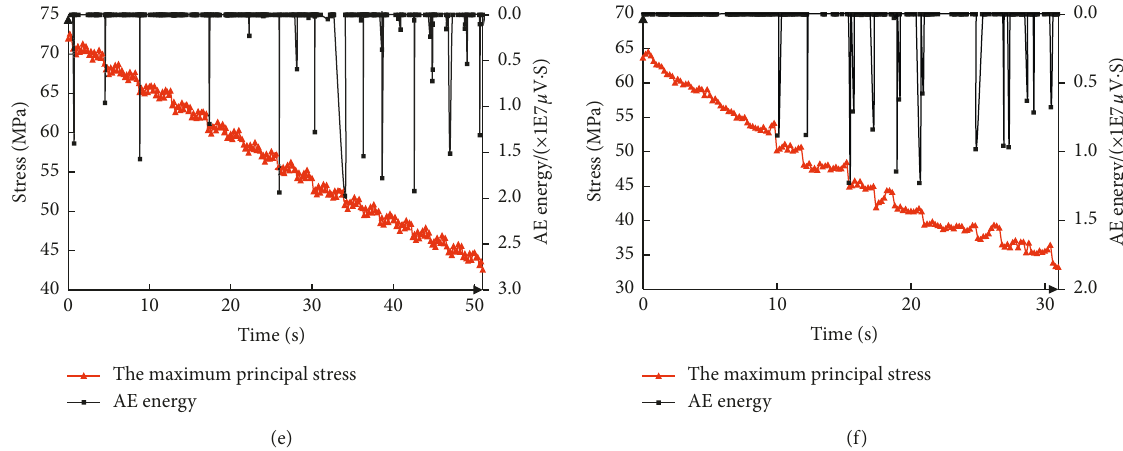
Figure 3: The major principal stress-time and AE energy-time curves of coal samples. (a) Sample M (rate: 2.77mm/min). (b) Sample N (rate: 6.12mm/min). (c) Sample O (rate: 4.26mm/min); (d) Sample P (data loss). (e) Sample Q (rate: 3.86mm/min); (f) Sample R (rate: 4.78mm/min).